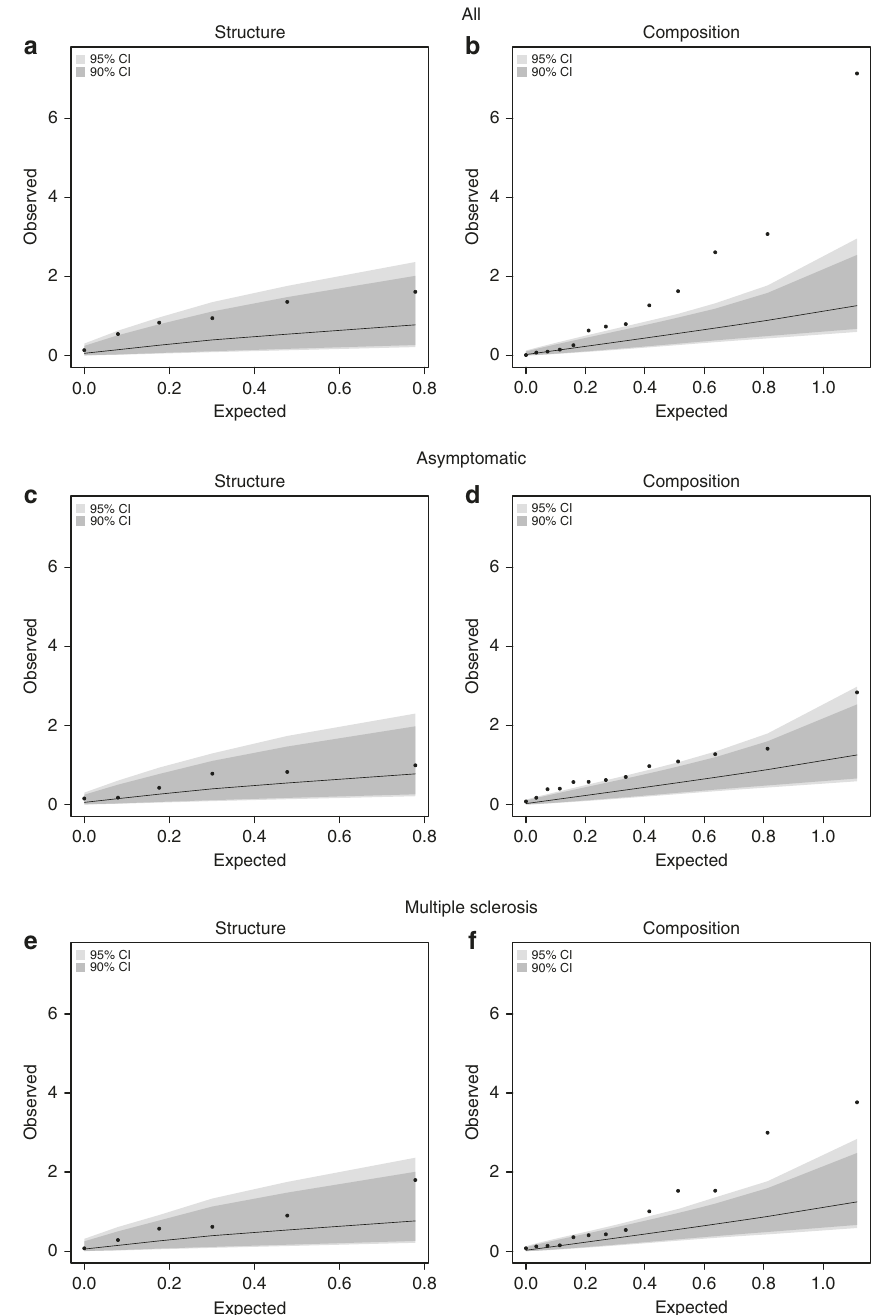
Fig. 4 Comparison of expected versus observed regression results. Quantile – quantile plot of expected versus observed P -values of composite network structure and network composition metrics in relation to neurological function and disability in the full cohort ( a , b ) and subgroups of asymptomatic ( c , d ) and MS participants ( e , f ). The expected P -values (-log10[P-value]) are shown on the x-axis and the observed P -values (-log10[ P -value]) are shown on the y-axis. The dark gray area indicate the con fi dence interval ranges as generated by chance at a threshold of P = 0.10 and the light gray is for P = 0.05. The observed values for composition, and not structure, are outside of the gray areas, suggesting that composition is associated with the MSRS-R score beyond chance after accounting for multiple testing burden and correlation structure of the composition